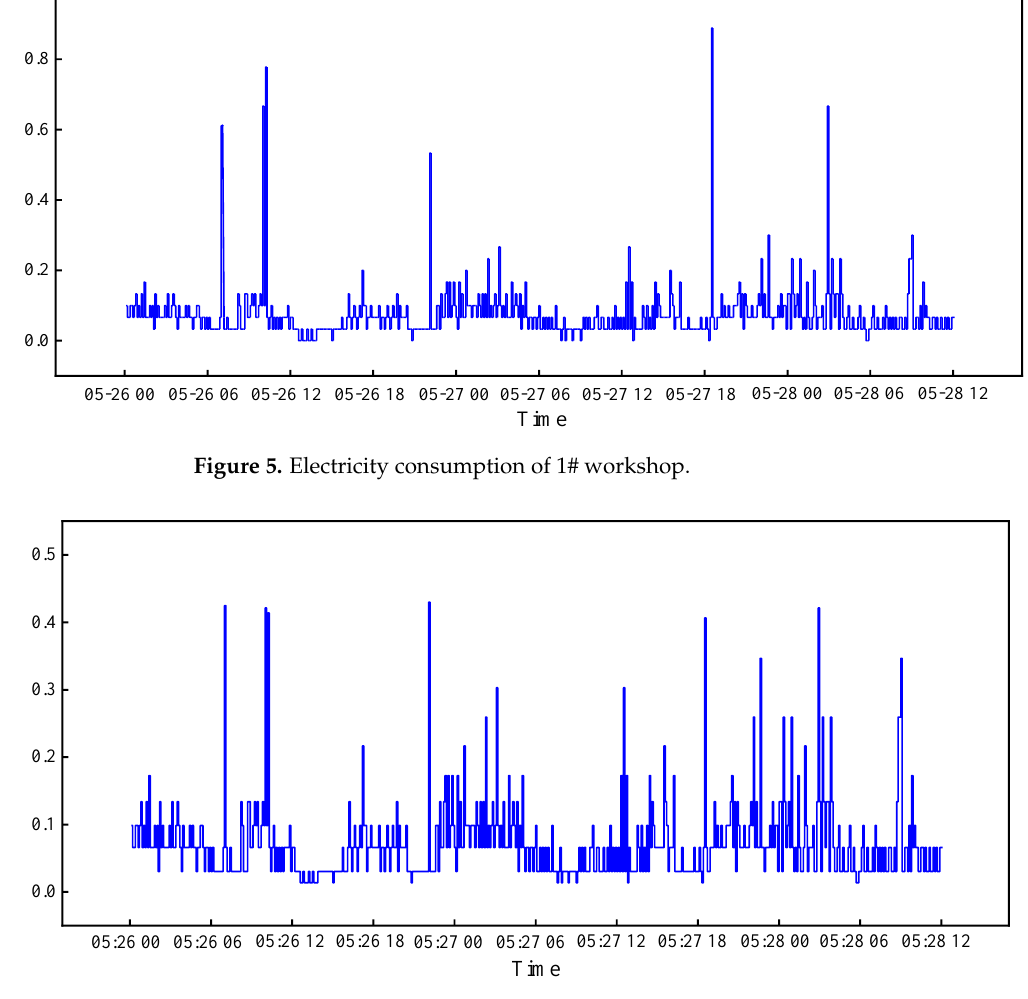
Figure 6. Electricity consumption reconstruction data of 1# workshop.